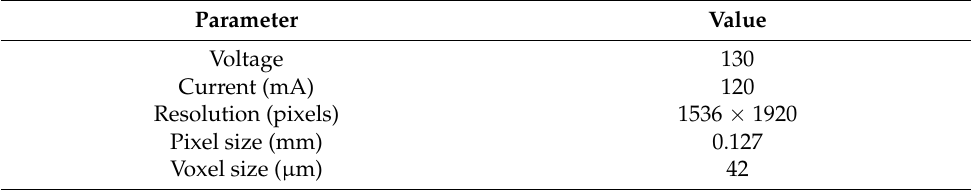
Table 2. Computerized tomography